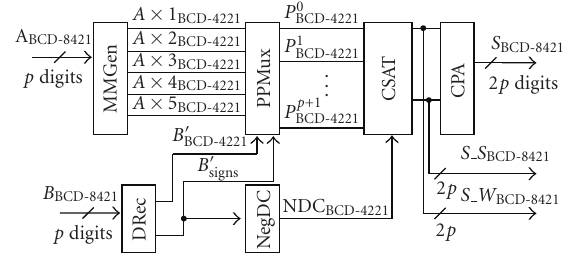
Figure 3: Parallel fixed-point